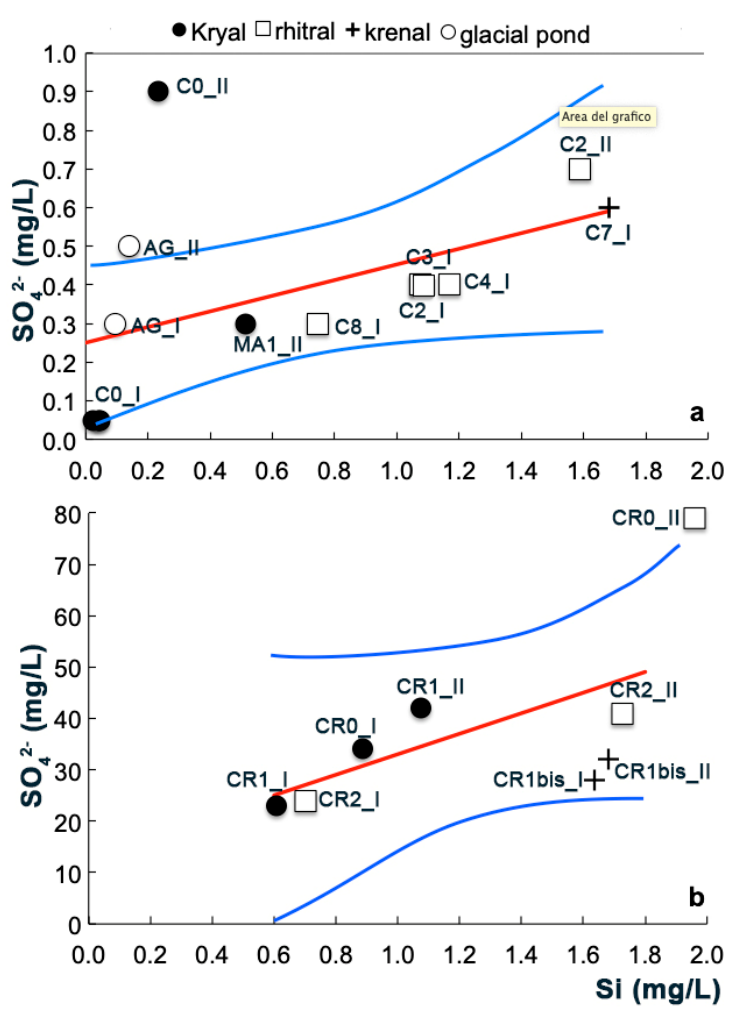
Figure 3. Binary diagram of SO4 2 − vs. Si. Samples are divided into four categories, as described in the text (kryal—black circle, rhithral—white square, krenal—black cross, glacial pond—white circle). ( a ) Data from the Conca, Agola and Mandrone streams; ( b ) data from the Careser stream, which is generally characterized by a higher sulfate concentration in relation to sulfur-rich metamorphic lithologies.